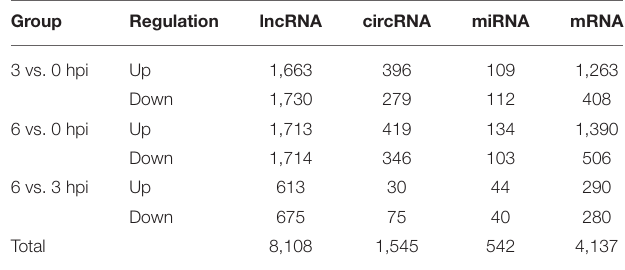
TABLE 1 | Summary of the number of differentially expressed ncRNAs and mRNAs.